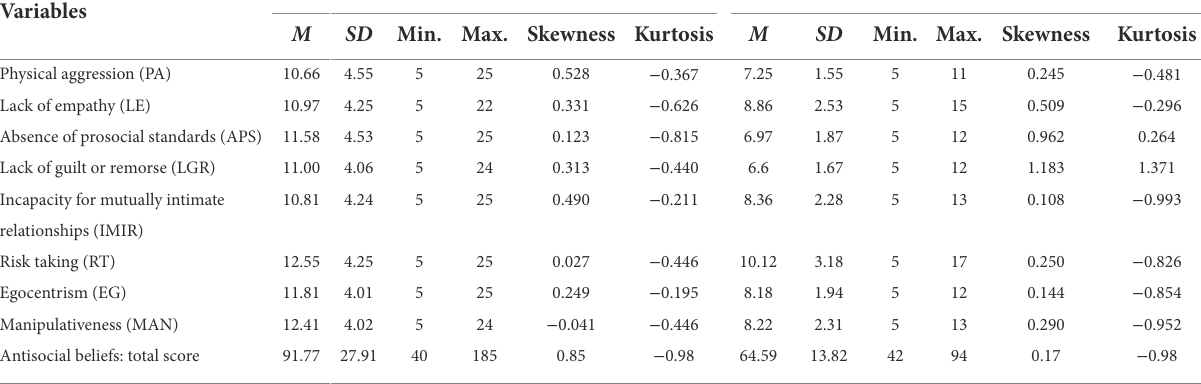
TABLE 2 Descriptive statistics for ABS factors: prisoners ( N = 718); non-offenders ( N = 339).